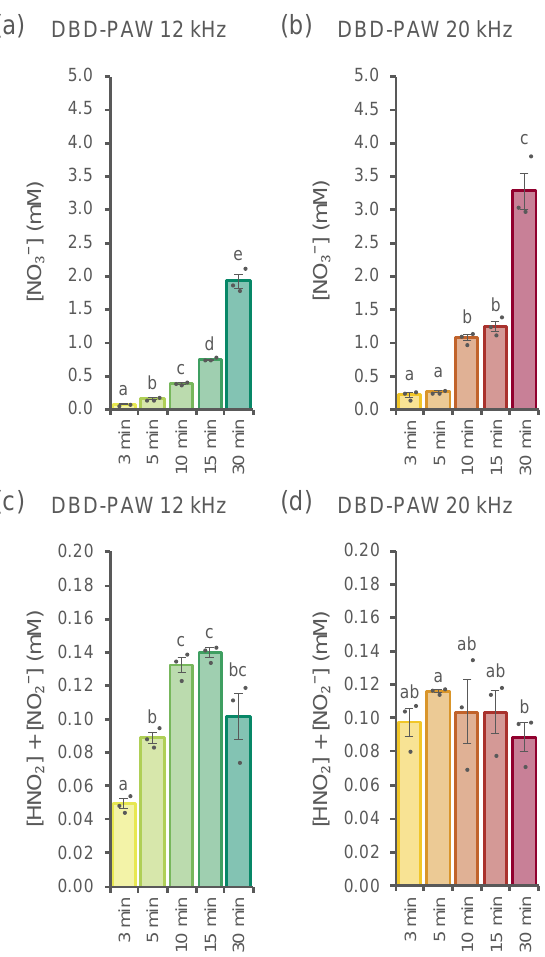
Figure 3. Quantification of the main nitrogen species in DBD-PAW. Ion chromatography analyses were performed on DBD-PAWs obtained at different discharge frequencies: ( a , c ) 12 kHz (green shades); ( b , d ) 20 kHz (red shades). DBD-PAWs were obtained by progressively increasing the exposure time of deionized H 2 O to the DBD cold plasma (from 3 to 30 min). Data are the means ± SE of 3 independent samples (dots). Statistical analyses were performed according to Student’s t test ( p < 0.05), with different letters indicating significant differences.